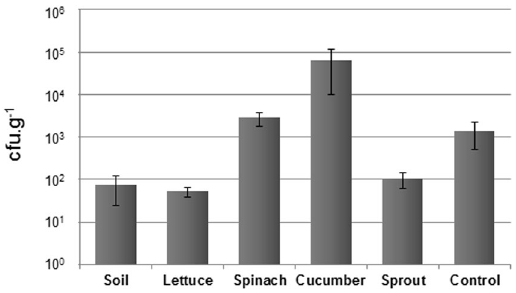
Figure 5. Transductants (cfu.g − 1 ) of phage 933W ∆ stx :: km in S . sonnei 866 generated in soil, lettuce, spinach, cucumber, and sprouts, and in LB broth at 23 °C. Results are the mean of four independent